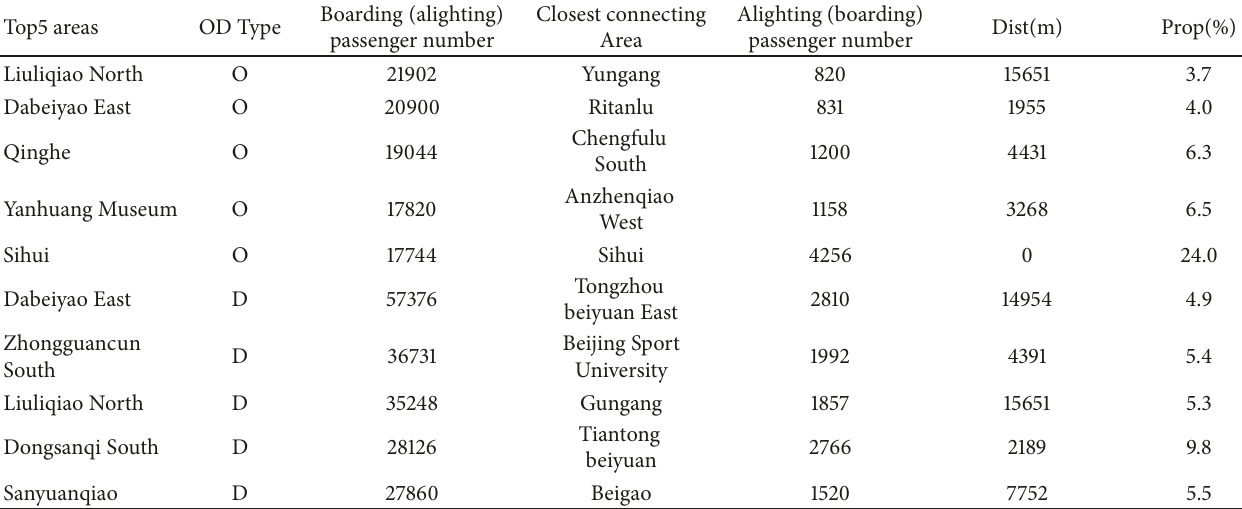
Table 5: The top five origin and destination areas in the morning and the most closely connected area to them. Top5